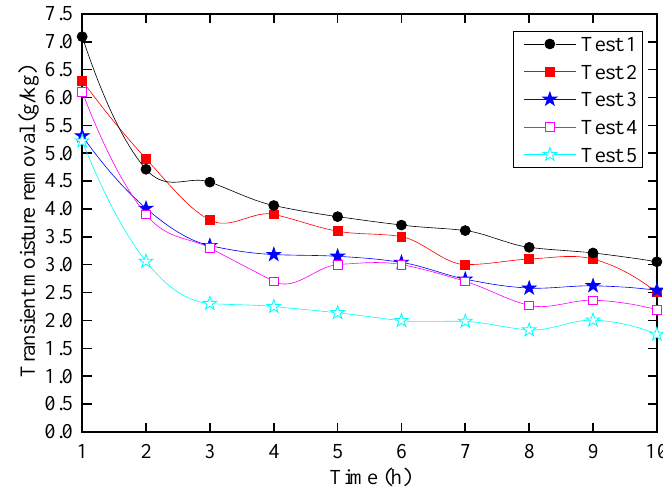
Figure 6. Variation of the transient moisture removal of the solid desiccant modules with time.